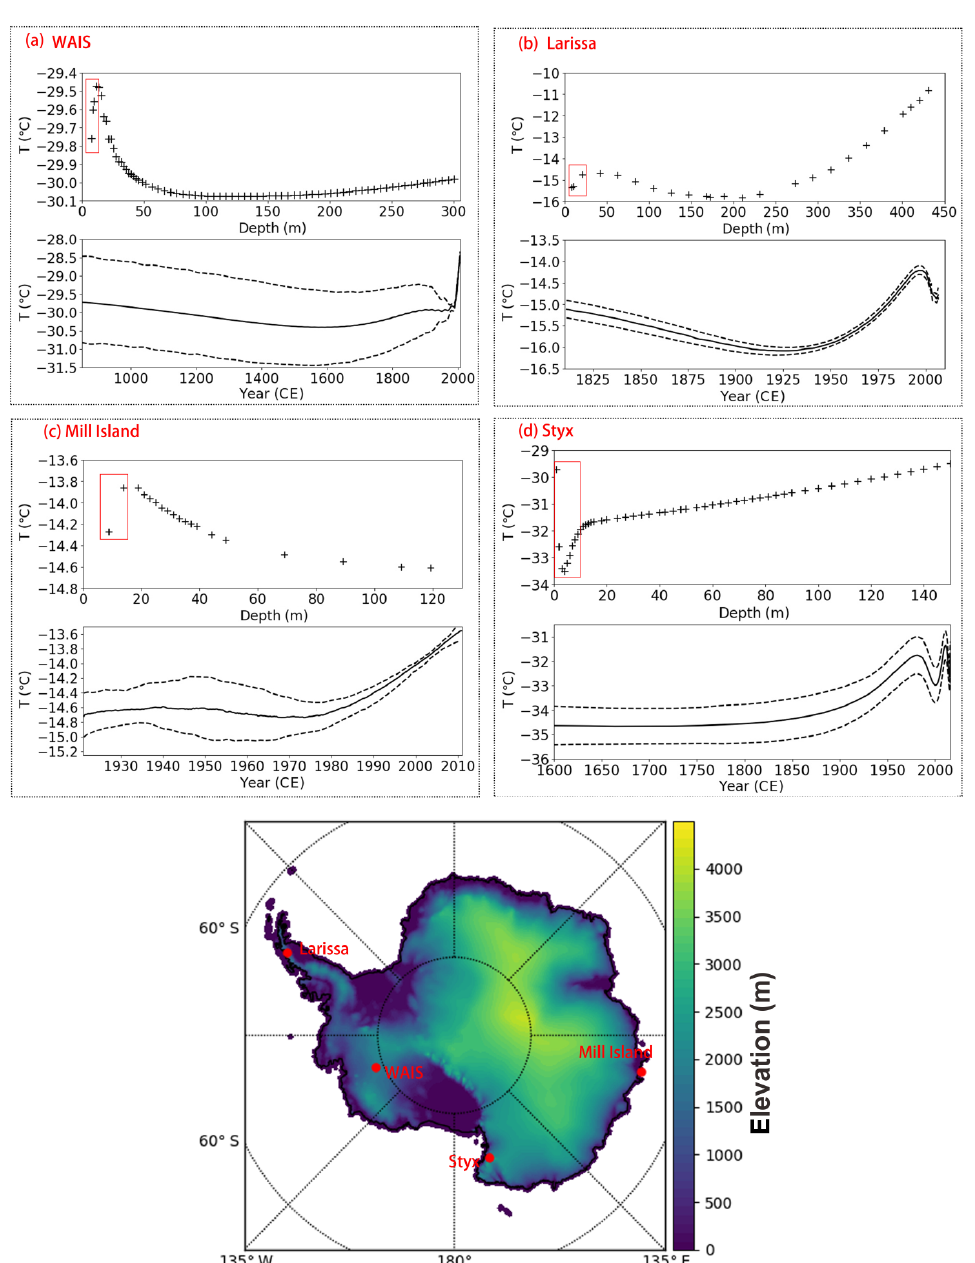
Figure 1. The observed borehole profiles and corresponding surface temperature reconstructions at the four sites in Antarctica. The sym- bols ( + ) show the measured borehole temperature. The dashed lines represent the reconstructed uncertainty, and the thick black lines are the mean reconstructed temperature. In panels (a) , (b) , (c) , and (d) , the red rectangles represent the borehole temperatures that are influenced by the seasonal cycle. The bottom panel shows the location of these four boreholes and their corresponding elevation over